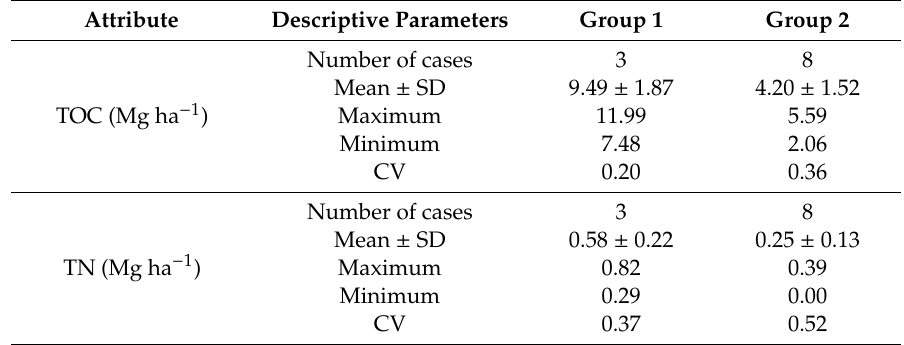
Table 2. Mean, minimum and maximum values, standard deviation and coe ffi cient of variation for the STK.TOC and STK.TN attributes in the typic eutrophic Litholic Neosol